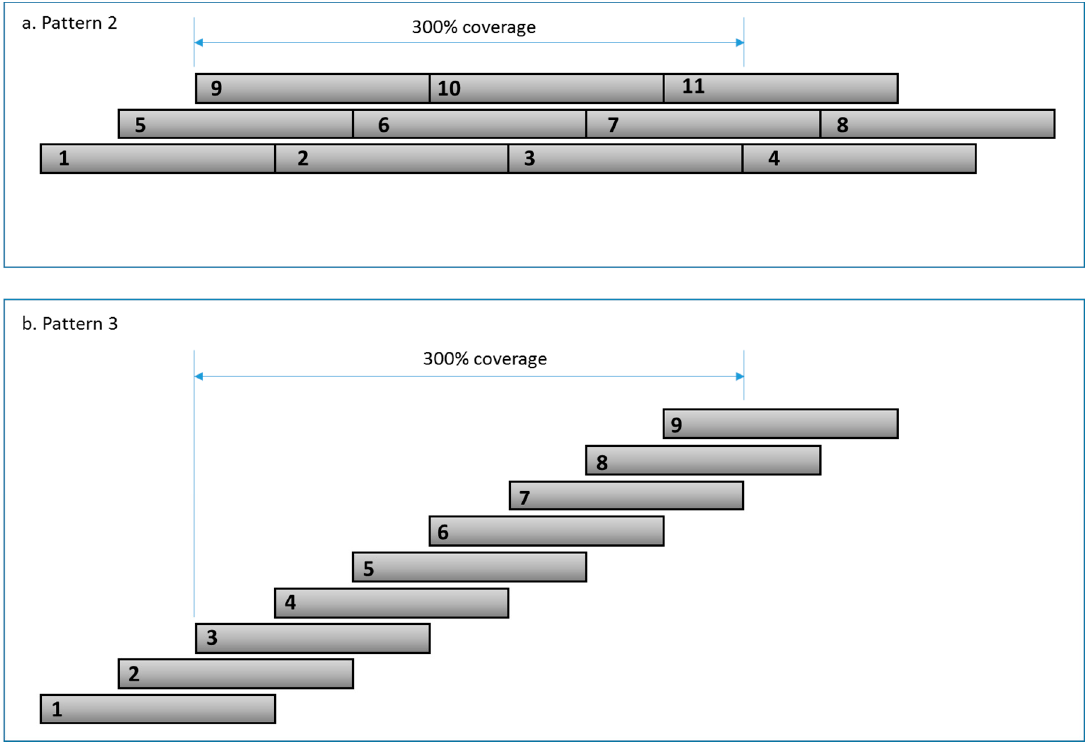
Figure 10. Schematics for achieving 300% peen coverage: ( a ) Pattern 2; ( b ) Pattern 3. Figure 8 shows Pattern 1.